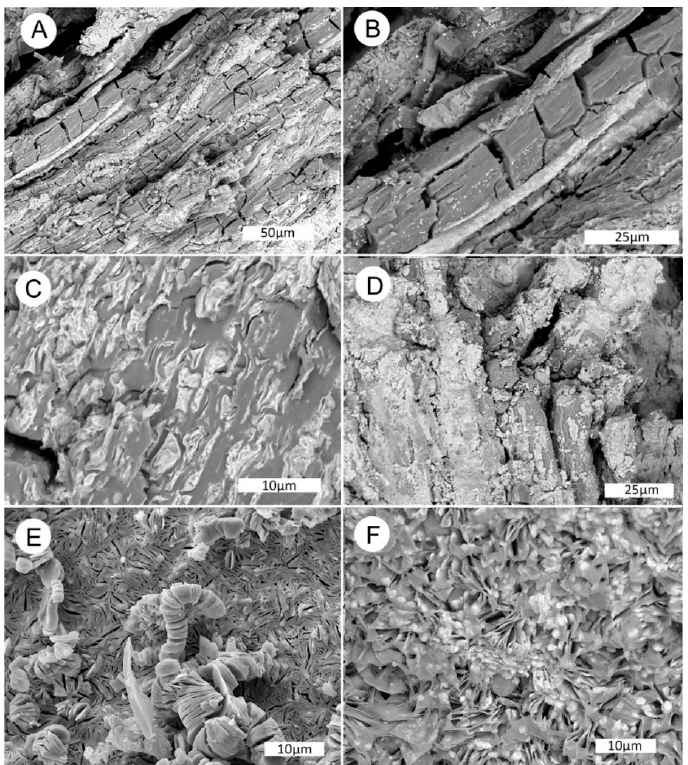
Figure 17. SEM images from Judd Claim sample. ( A , B ) carnotite occurs in layers within carbonized wood, visible as bright zones in these BSE images. Note the constellation of tiny bright spots in the fractured carbonized wood in image B. ( C ) Transverse view, showing carnotite filling lumina. Cell walls are carbonized. ( D ) Longitudinal view, showing wood cells encrusted with patchy carnotiite. ( E ) Pure carnotite showing crystal habit. ( F ) Platy clay minerals sowing disseminated carnotite.